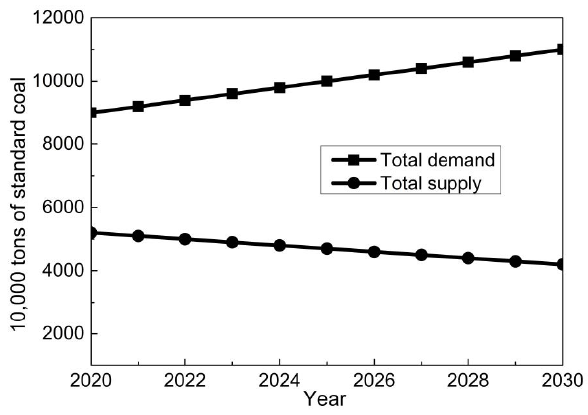
Fig. 9 Forecast of coal supply and demand